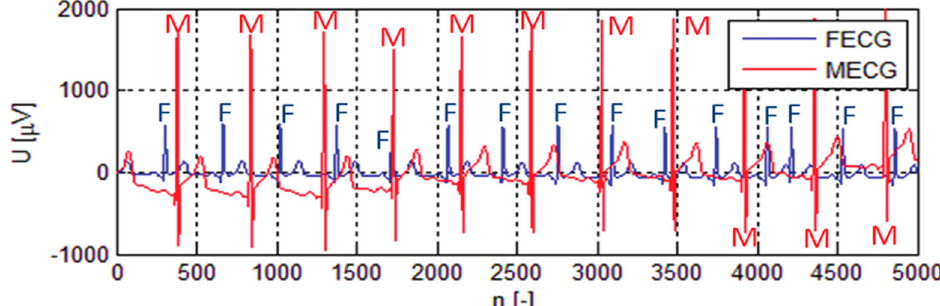
Figure 2. The example of FECG embedded within the MECG signal [45] (Reprinted with permission from ref [45] Radek Martinek (2012)).